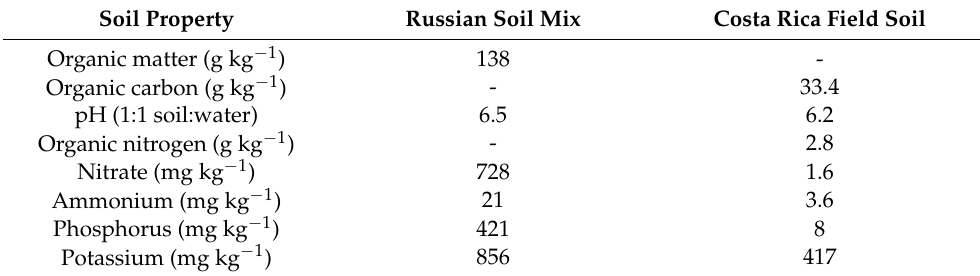
Table 1. Chemical properties of soil analyzed from Russia and Costa Rica. Soil